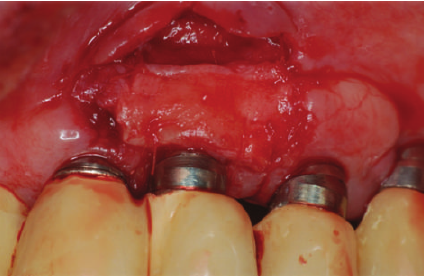
Figure 8: Connective tissue graft sutured to the recipient